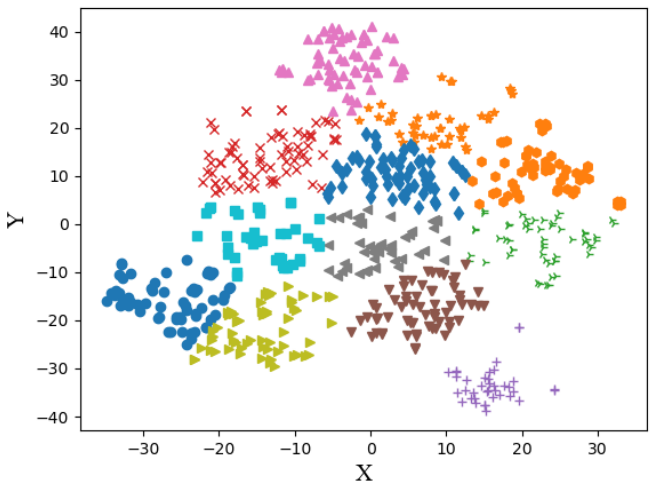
Figure 7. Visualization of 12 clusters in two-dimensional space where different colors represent different categories.